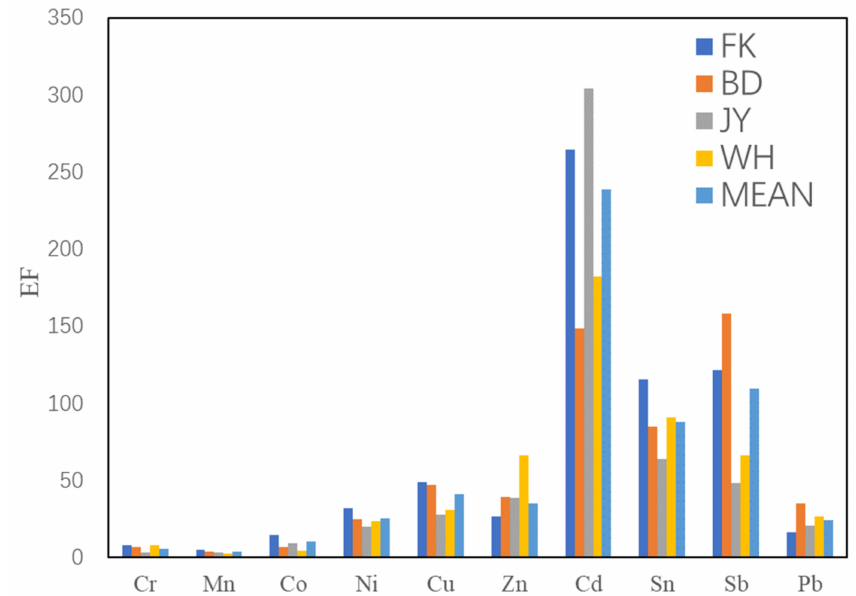
Figure 4. Enrichment factors of metals in PM 2.5 at roadside.